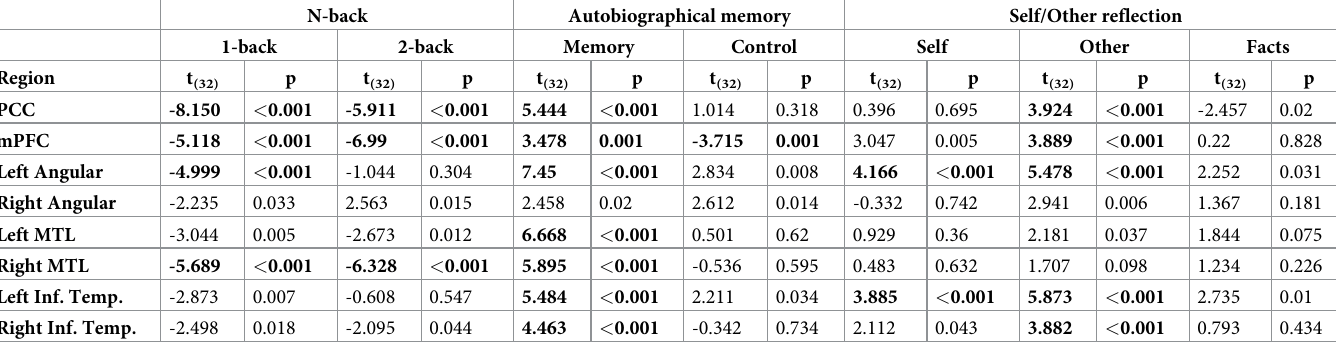
Table 5. Significant activations for the ROI